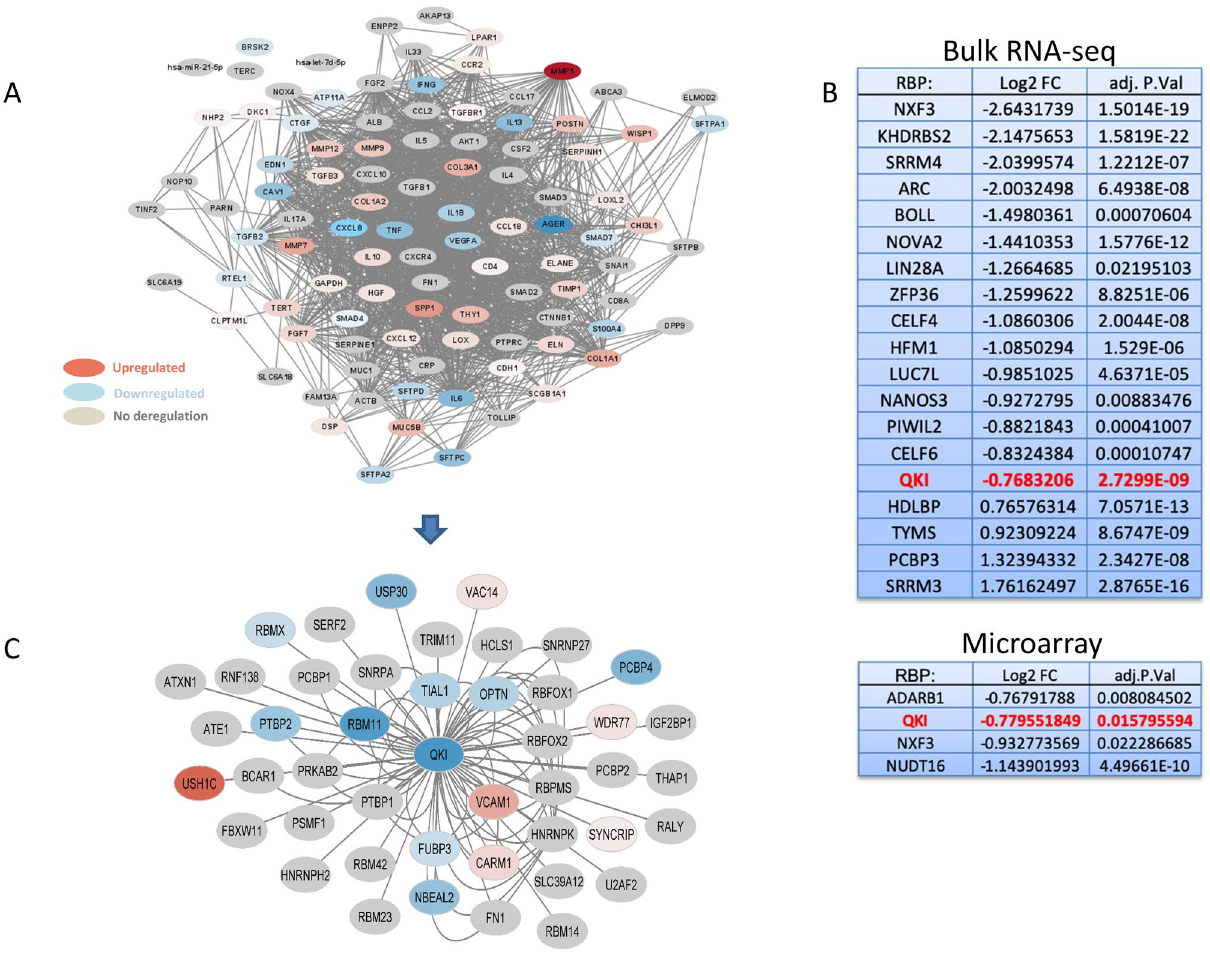
Figure 1. ( A ) IPF-associated disease network showing regulation of known pathophysiological players deregulated in the bulk RNA-Seq (GSE92592) of IPF (n = 20) vs control (n = 19). Nodes represent an interaction partner, edges represent interactions; color scaling shows the deregulation in IPF (red: upregulation, blue: downregulation). ( B ) Extract of annotated RBPs (GO:0003729 = mRNA binding) gene expression in the two independent human IPF datasets (GSE92592, GSE53845). ( C ) QKI-interactome (45 nodes, 87 edges) illustrating interaction partners around QKI and its regulation in a high-throughput RNA-Seq data of human IPF. Nodes represent an interaction partner, edges represent interactions; color scaling shows the deregulation in IPF (red: upregulation, blue: